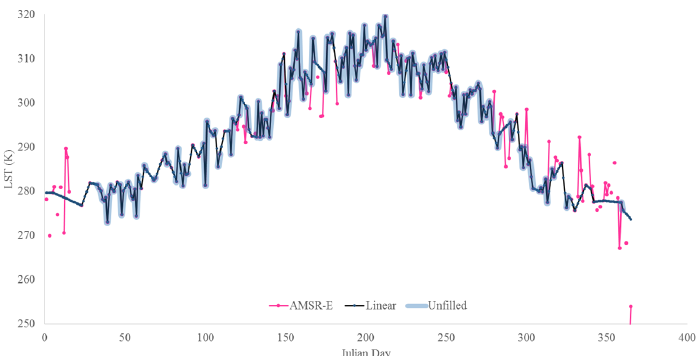
Figure 3. Example of LST gap-filling for one site in the JDR in 2003. Blue highlight is the original unfilled LST data: pink lines and points are gap-filled using the AMSR-E method and the black line is gap-filling using a simple linear interpolation.